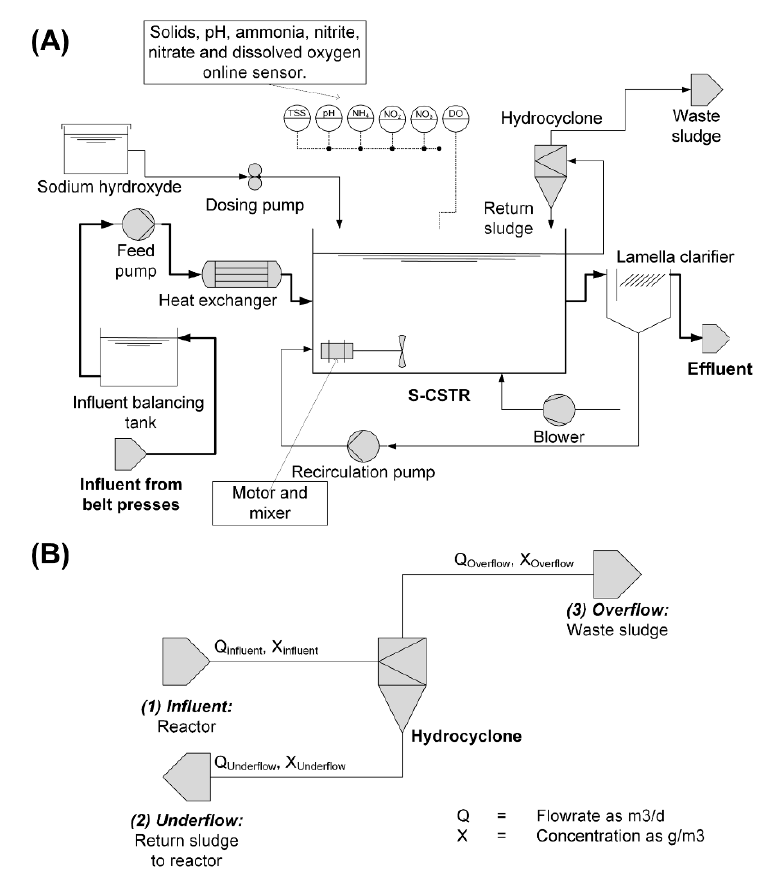
Figure 1. ( A ) Flowchart of the suspended sludge continuous stirred tank reactor (S-CSTR) and ( B ) schematic representation of the mass-balance to the hydrocyclone.